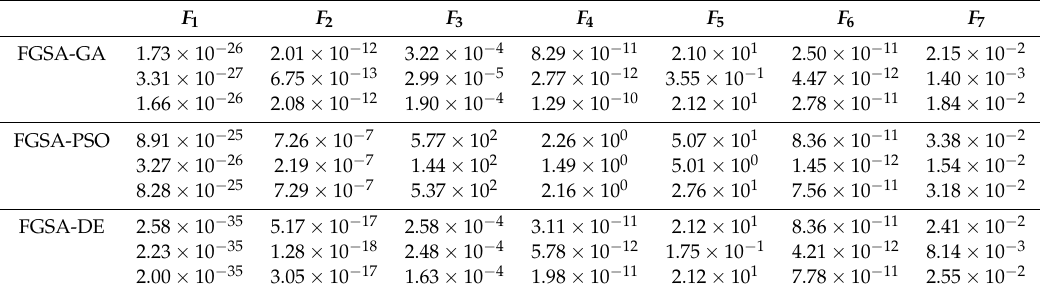
Table 5. Comparisons between FGSA-GA, FGSA-PSO and FGSA-DE over 16 runs for unimodal functions.